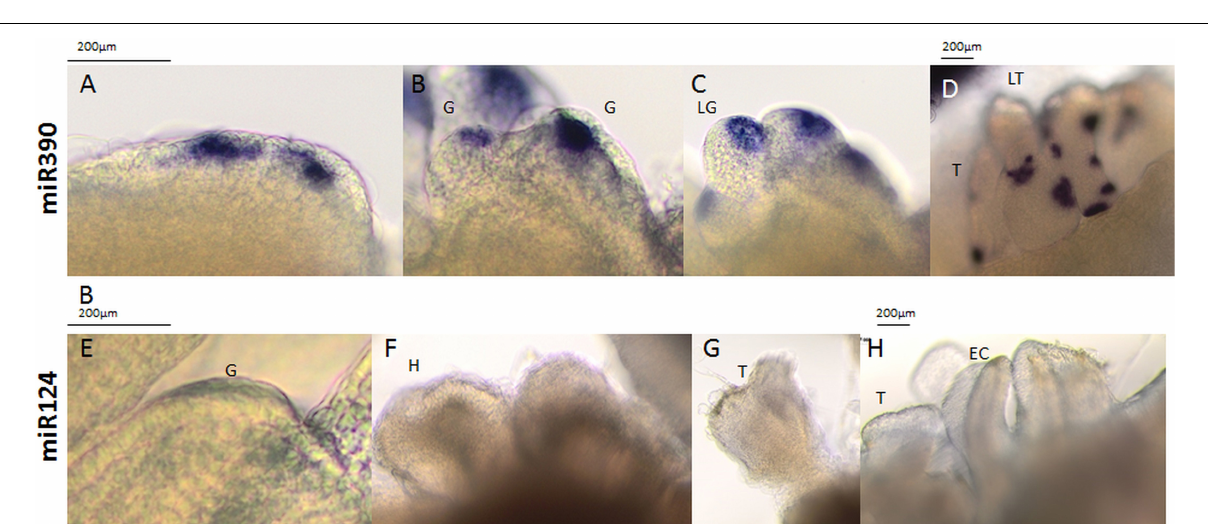
FIGURE 6 | Whole mount in situ hybridization of the miR390 molecules (A–D) in the explants undergoing SE induction in WT on the 15th day of the culture. Probes against the mouse miR124 were used as the negative control (E–H) . All of the images show the somatic embryos during the globular (G), late globular (LG), heart (H), torpedo (T), late torpedo (LT), early cotyledonary (EC), cotyledonary (C), and mature stages of development